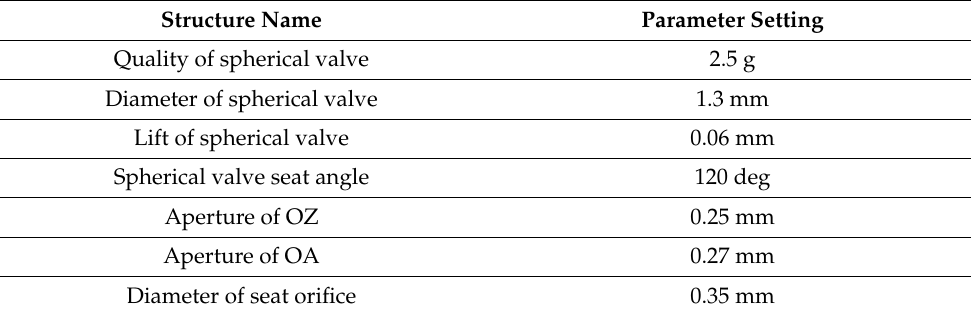
Table 1. Structural parameters of the control valve.